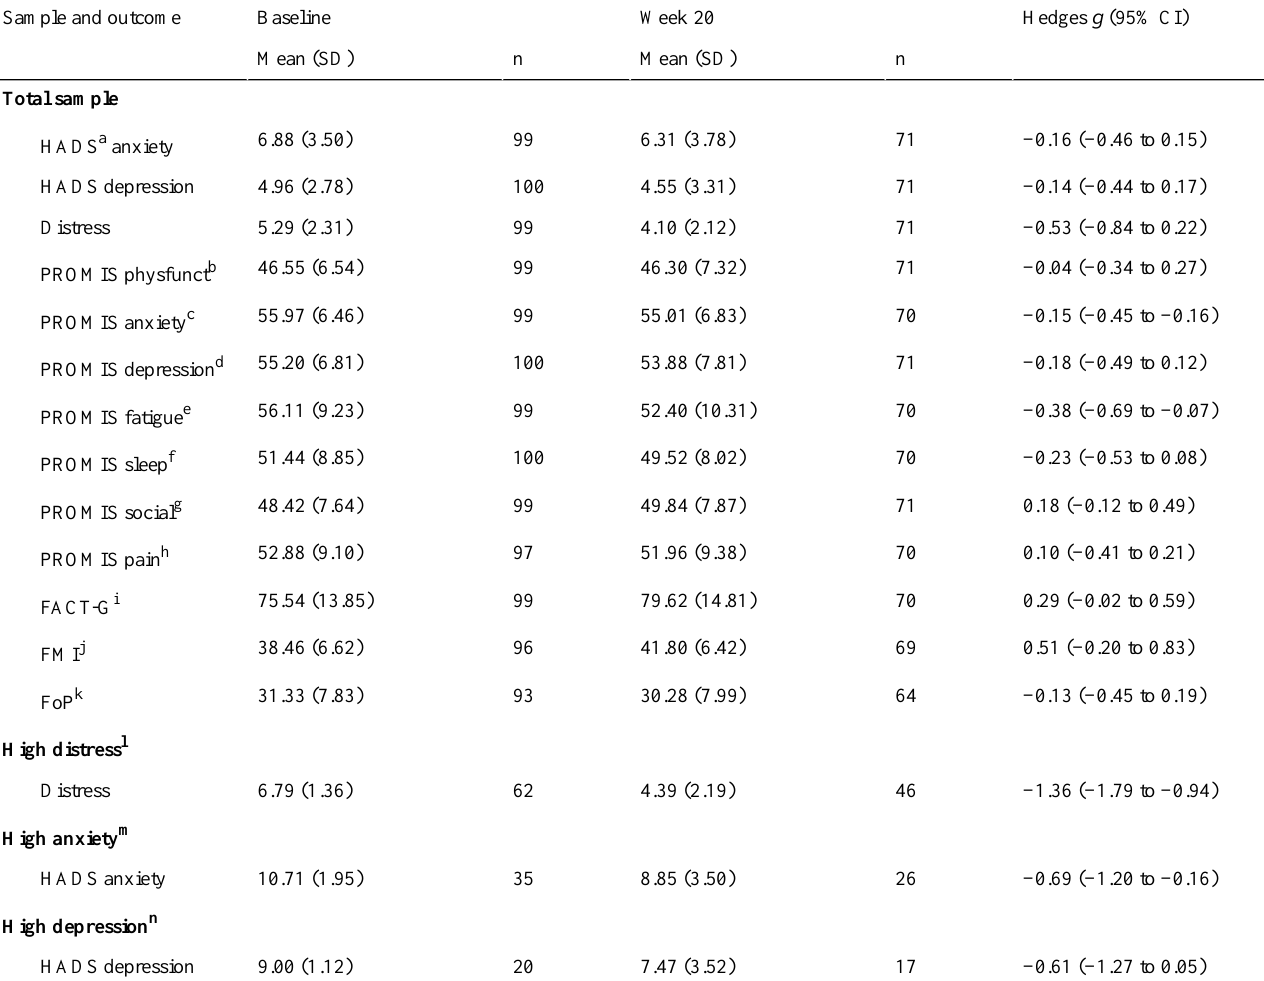
Table 2. Mean values of health outcomes at baseline and week 20, response rate (n), and effect sizes